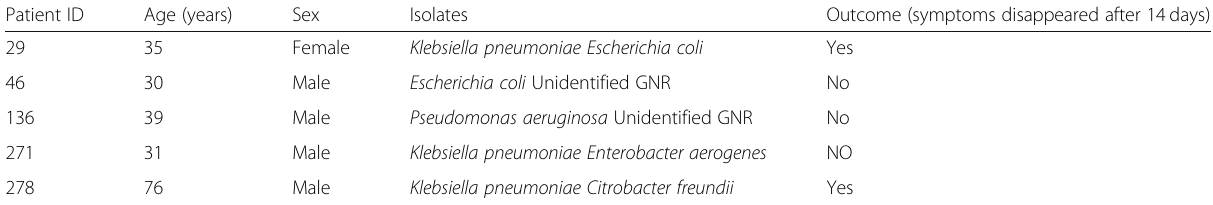
Table 2 Patients with more than one